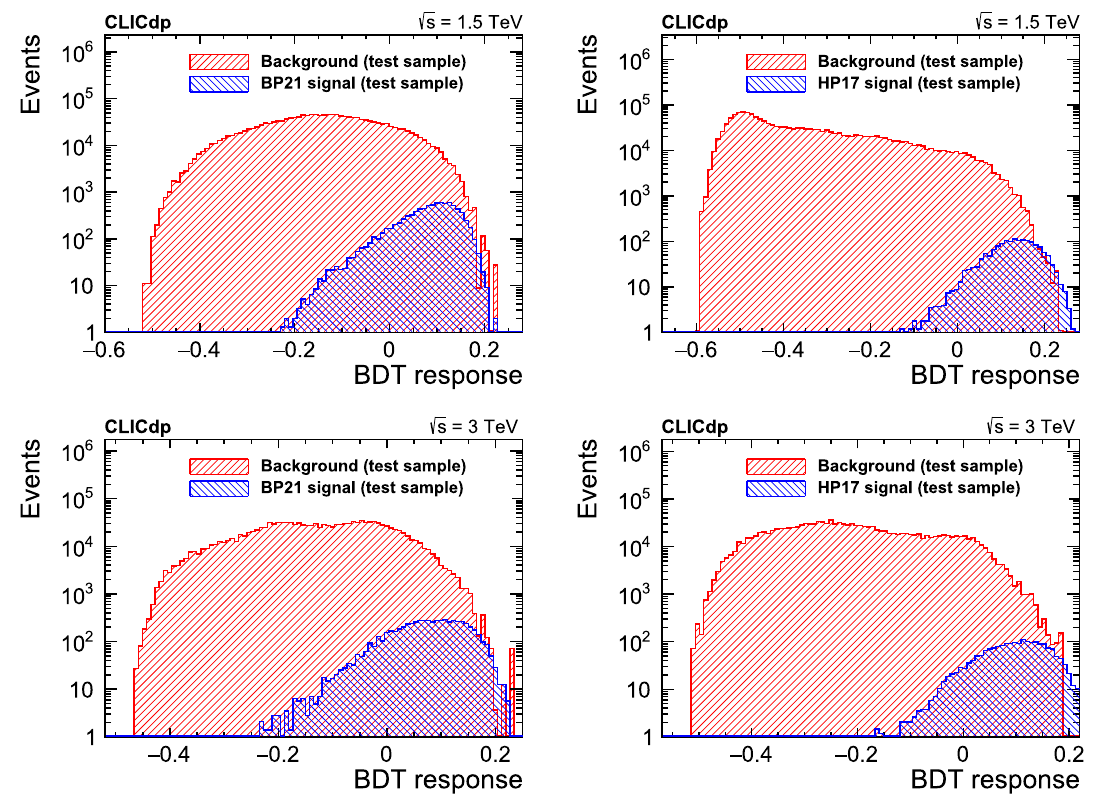
Fig. 4 BDT response distributions for the BP21 (left) and the HP17 (right) scenarios at √ s plots). Benchmark scenarios and SM background expectations are normalised to the integrated luminosity of 2ab − 1 and 4ab − 1 , for 1.5TeV and 3TeV, respectively. All of the presented distributions were obtained with full detector simulation and maximal achievable significance with them exceeds 5